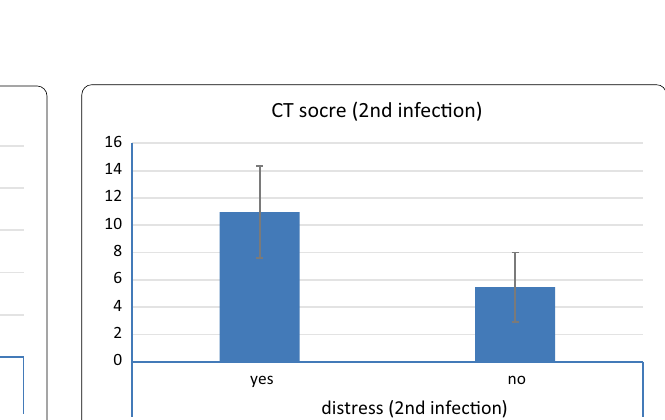
Fig. 6 Relation between CT severity score and respiratory distress Fig. 7 Relation between CT severity score and respiratory distress during second infection